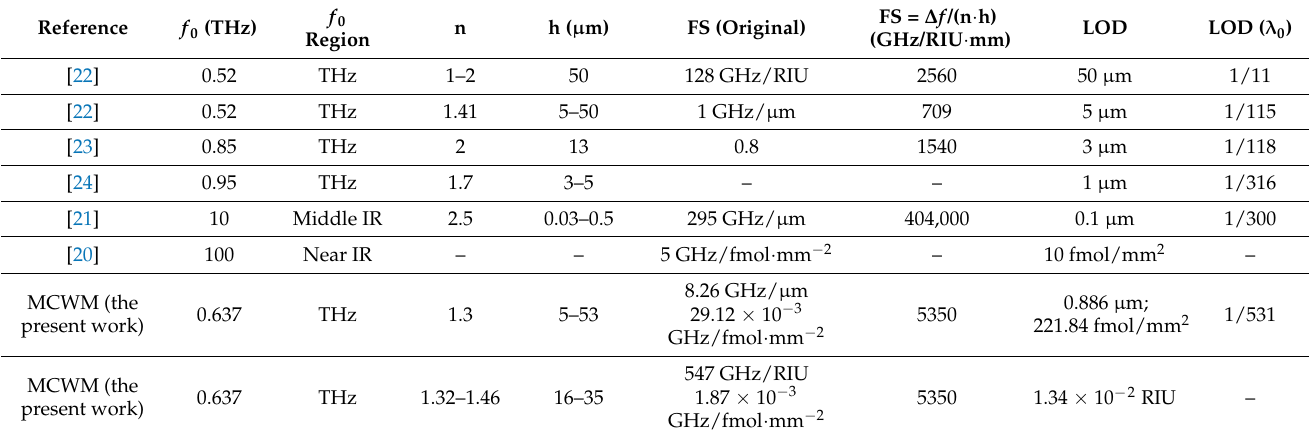
Table 3. Sensing performance comparison among the MHA, MMD, and MCWM device